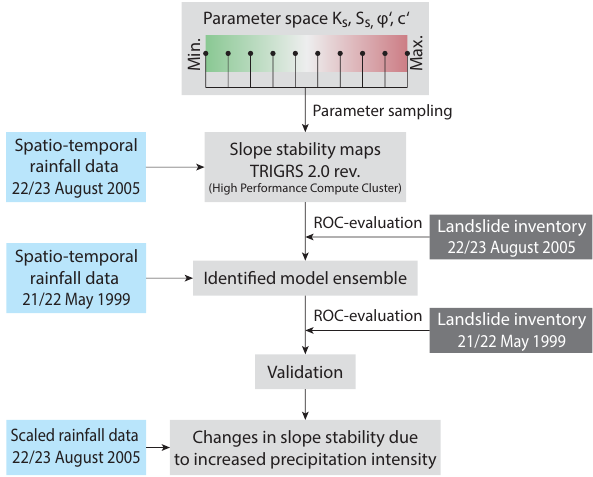
Figure 1. Workflow with the main steps of the